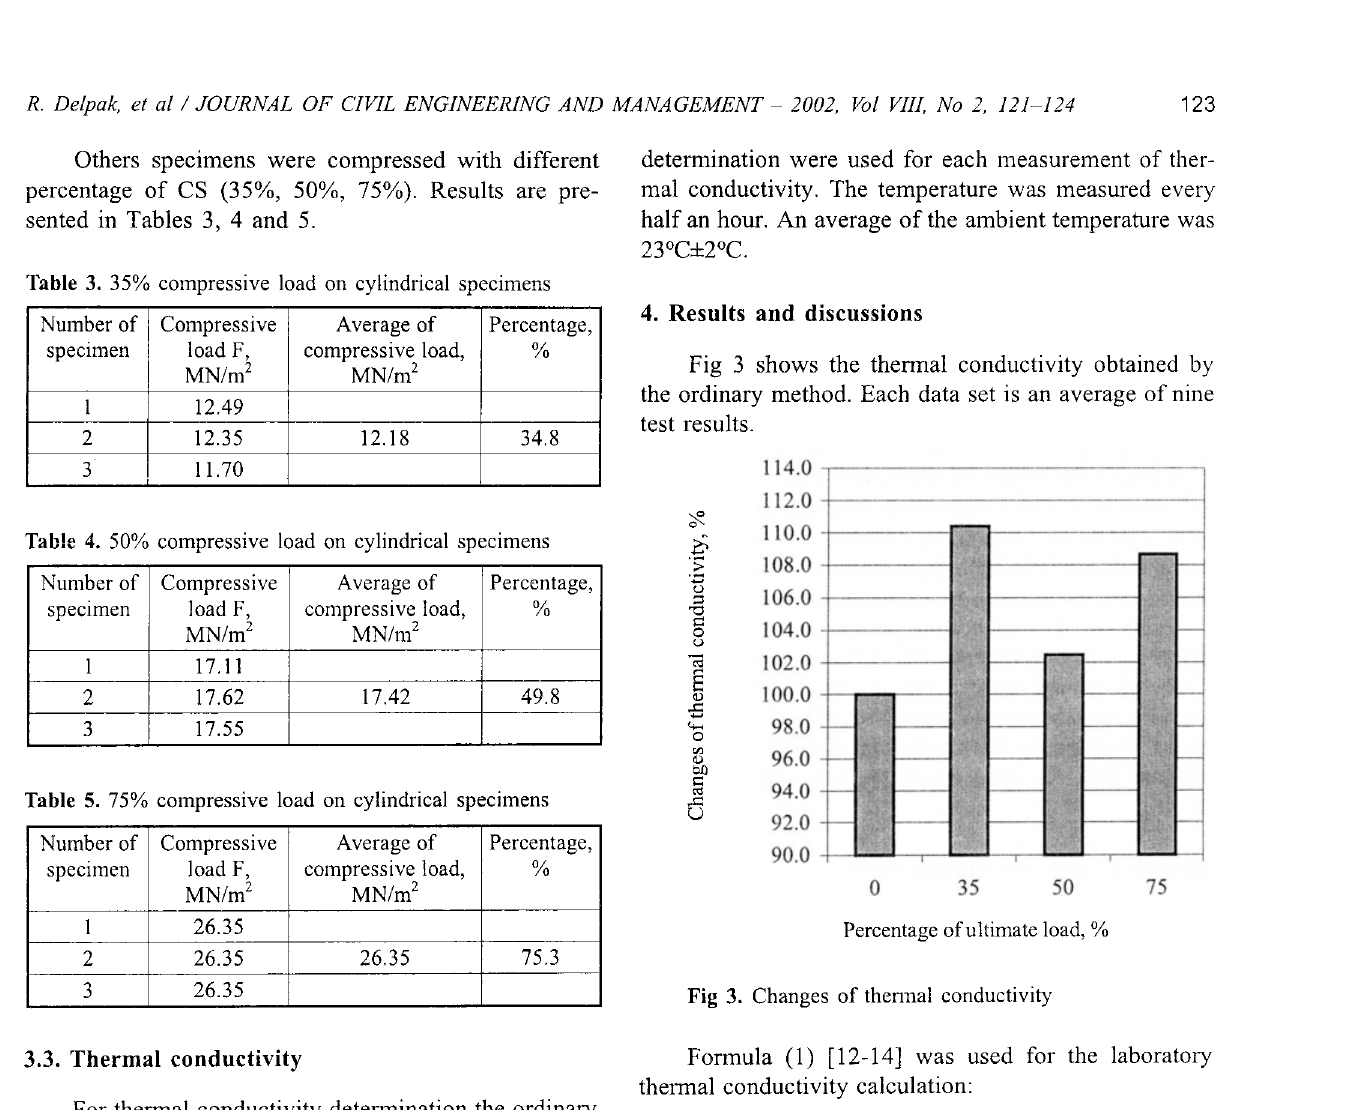
Fig 3. Changes of thennal conductivity